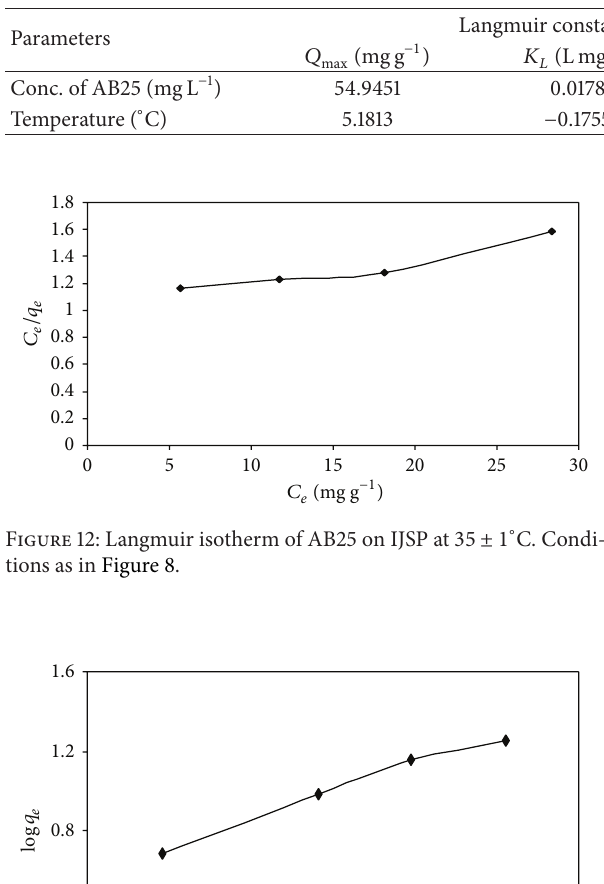
Table 6: Biosorption isothermal parameter values for the removal of AB25 on IJSP at different concentrations of AB25 and temperatures of AB25 solution. Conditions as in Tables 2 and 4.